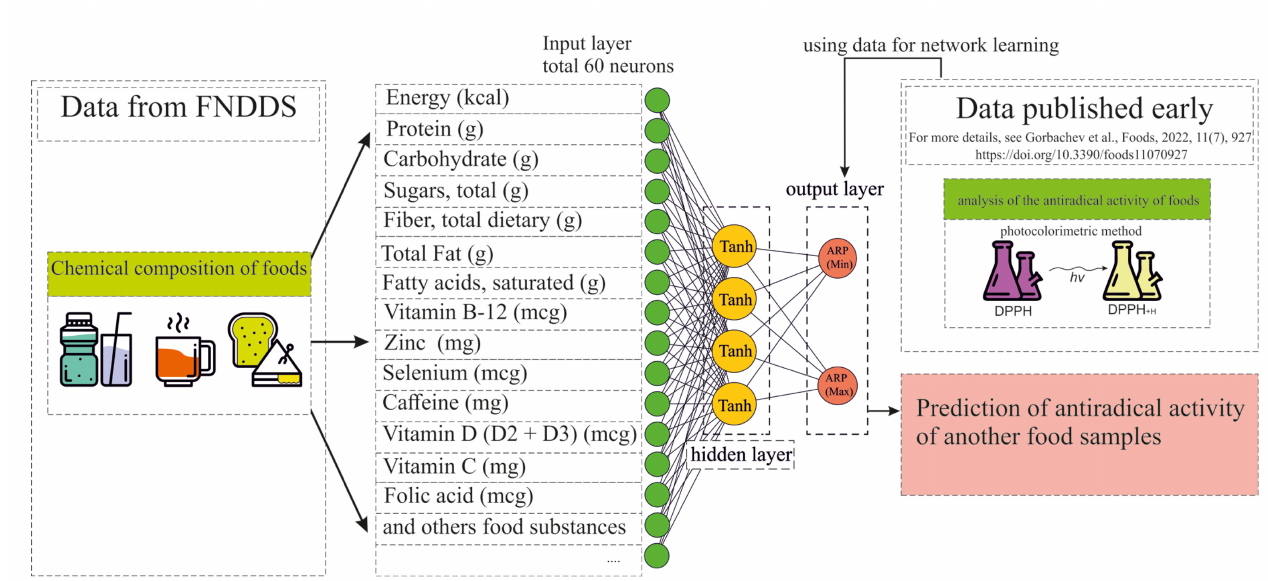
Figure 1. The scheme of a neural network with the structure of an MLP, with highlighted stages of the study